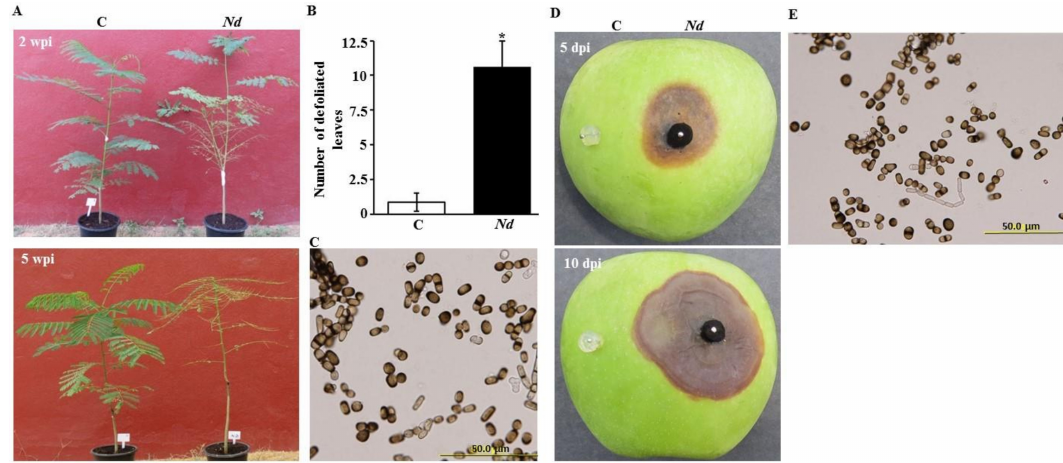
Figure 4. Development of canker on royal poinciana seedlings and apple fruits following artificial inoculation with Neoscytalidium dimidiatum. Pathogenicity test on royal poinciana seedlings inoculated ( Nd ; right) and non-inoculated (C; left) with N. dimidiatum at ( A ) 2 and 5 wpi; ( B ) number of defoliated leaves of inoculated and control seedlings; and ( C ) conidia after re-isolation of the pathogen from colonized stem tissues, at 5 wpi. Pathogenicity tests on ( D ) inoculated (right) and non-inoculated (left) apple fruits at 5 and 10 dpi; and ( E ) conidia of the pathogen from the inoculated apple fruits at 10 dpi. In ( B ), mean values followed by an asterisk are significantly di ff erent from control treatment at the tested time ( p < 0.05). Experiments were repeated at least three times with similar results. C, control (no N. dimidiatum ); Nd , N. dimidiatum .; dpi / wpi, days / weeks post